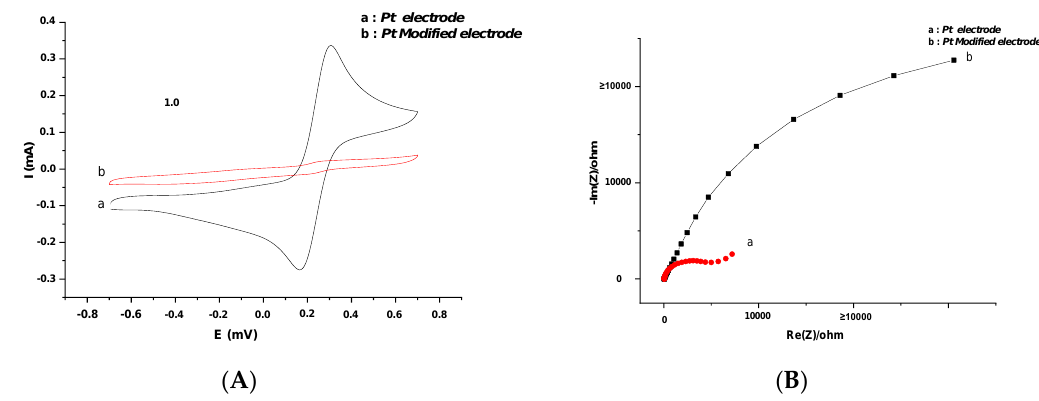
Figure 5. ( A ) Voltammograms at 50 mVs −1 and ( B ) Diagram of Nyquist at −200 mV potential, of (a) Pt bare electrode and (b) Pt electrode modified with an enzymatic membrane in phosphate buffered saline (PBS) solution (0.1 M). In the presence of Fe (CN 6 ) 3−/4− .